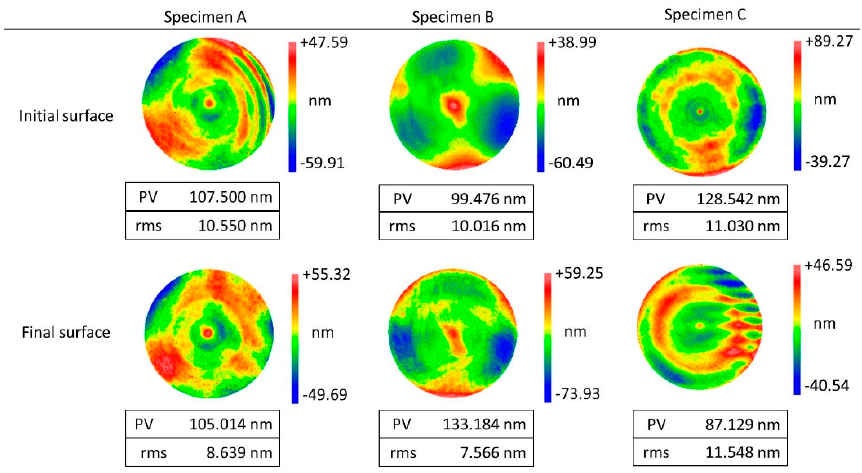
Figure 14. Profile of the initial and final surface form errors in test C.